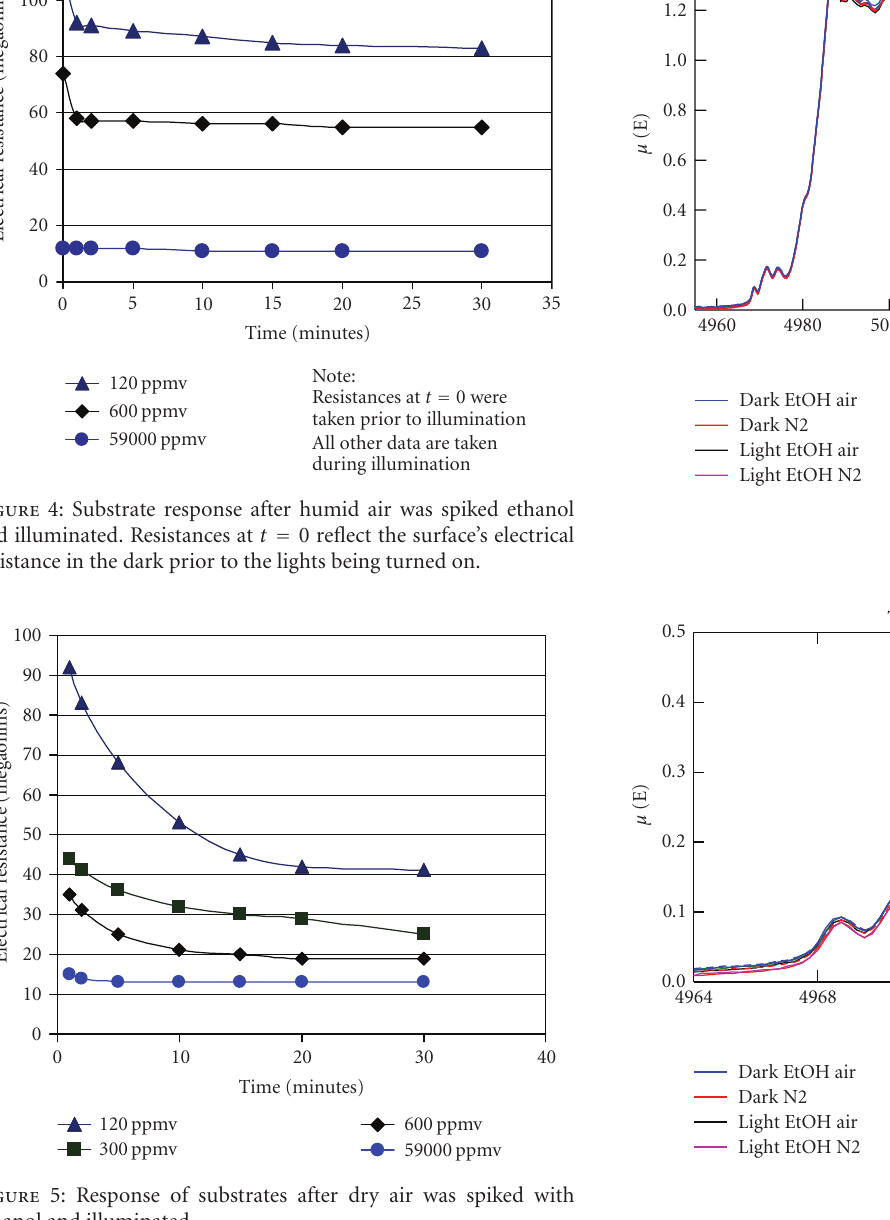
Figure 6: The XAFS spectra for the sensor. The labels designate the following atmospheric conditions during X-ray interrogation. “Dark EtOH air” indicates a saturated ethanol atmosphere in darkness; “dark N2” indicates a nitrogen atmosphere in darkness; “light EtOH air” indicates a saturated ethanol atmosphere while the sensing surface is illuminated; “light EtOH N2” indicates a nitrogen atmosphere saturated with ethanol while the sensing surface is illuminated; “light N2” indicates a nitrogen atmosphere while the sensing surface is illuminated; “light” indicates a dry air atmosphere while the sensor is illuminated; and “sensor 2” indicates a dry air atmosphere while the sensor is kept in darkness. Figure 6(b) is the magnified X-ray absorption near edge spectroscopy (XANES) portion of the spectra and describes the valence state of